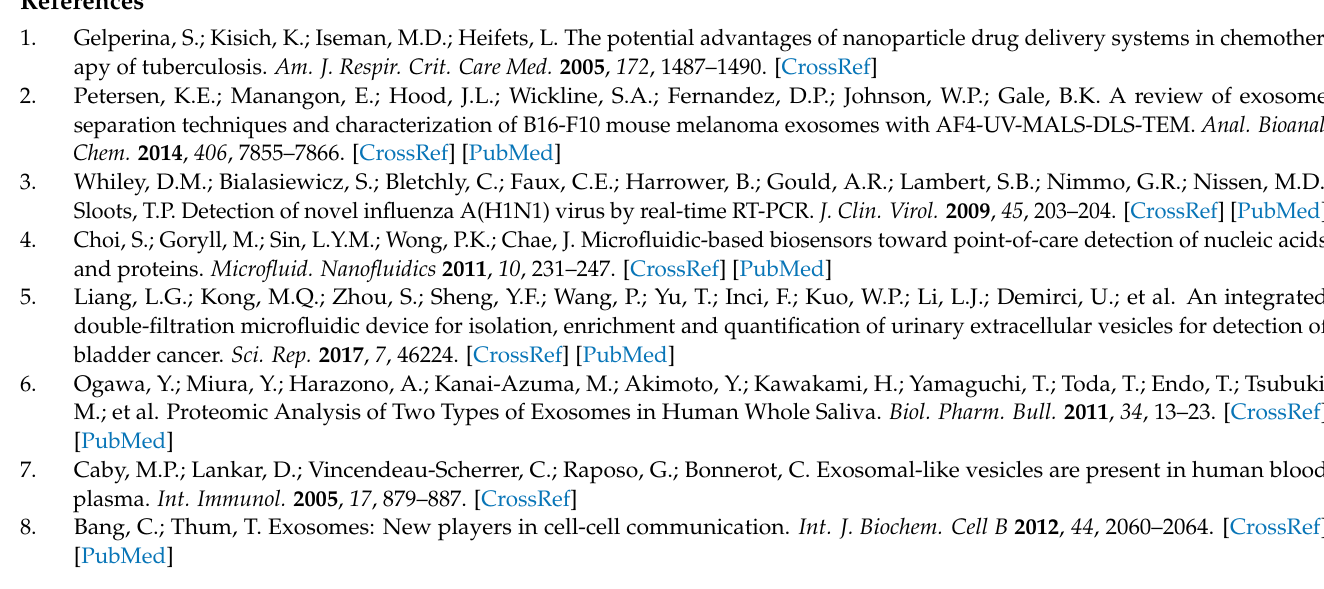
Figure S2: Effect of particle size on the number of particles adsorbed on PDMS-based substrates, Figure S3: Effect of particle size on the number of particles adsorbed on PDMS-based microchannels, Table S1: Effect of mixing time on the zeta potentials of PDMS-based